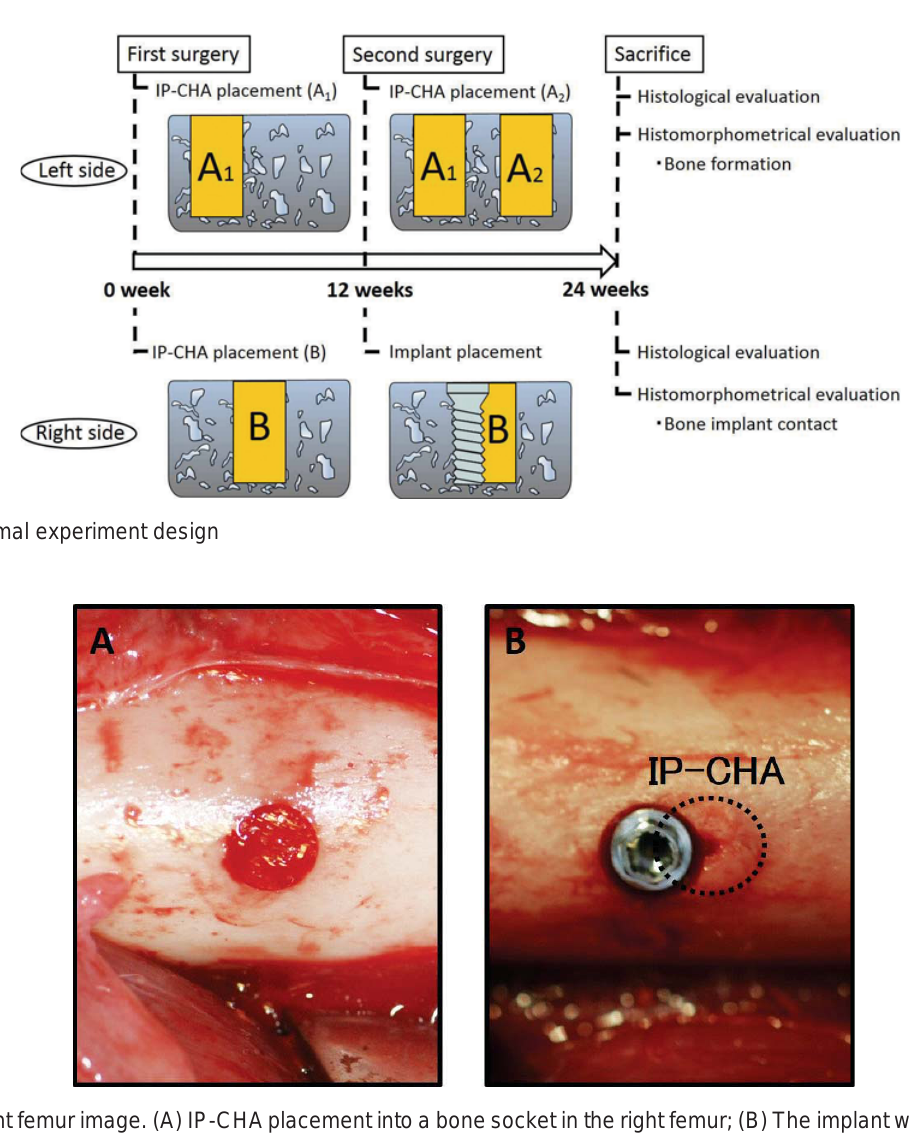
Figure 3- Right femur image. (A) IP-CHA placement into a bone socket in the right femur; (B) The implant was placed in the grafted IP-CHA, with half of the implant contacting the IP-CHA surface. The dotted line indicates previously grafted